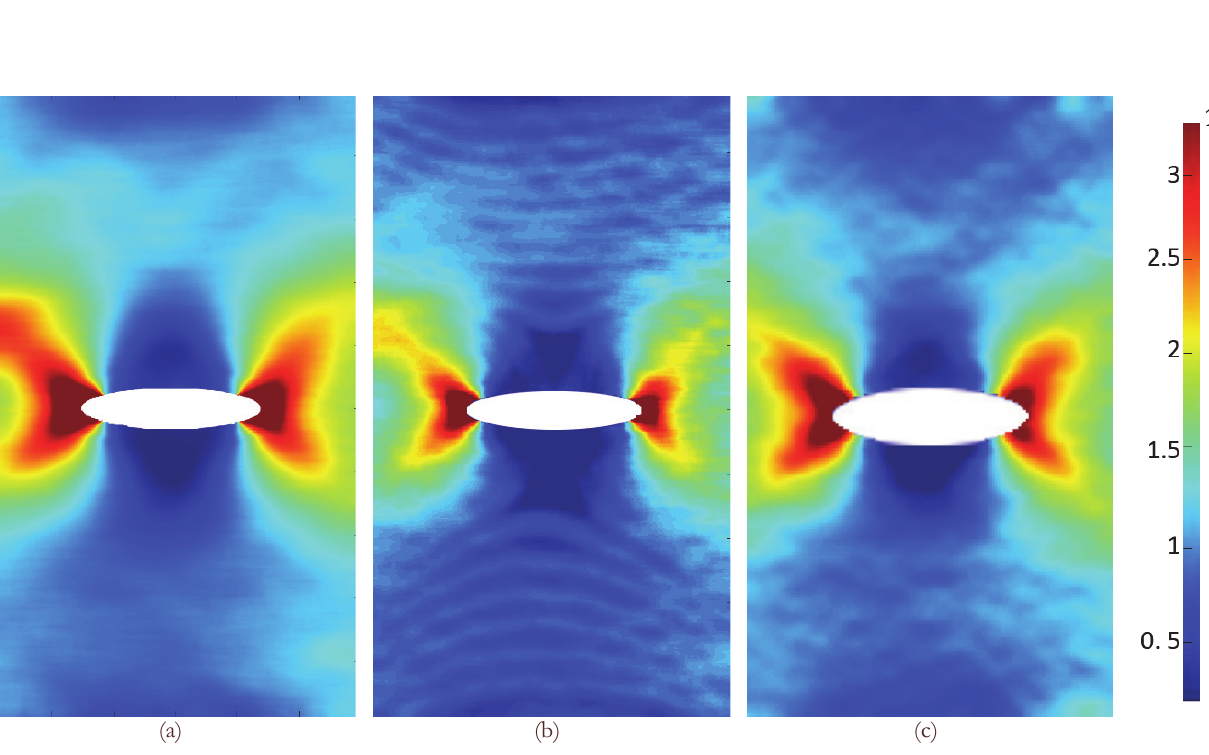
Figure 4: Map of the strain along X axis [-] of the elliptical hole with an aspect ratio 0.1 normal to the load axis. Results computed, in order of appearance, with (a) LSM, (b) SGM, (c) NCORR.